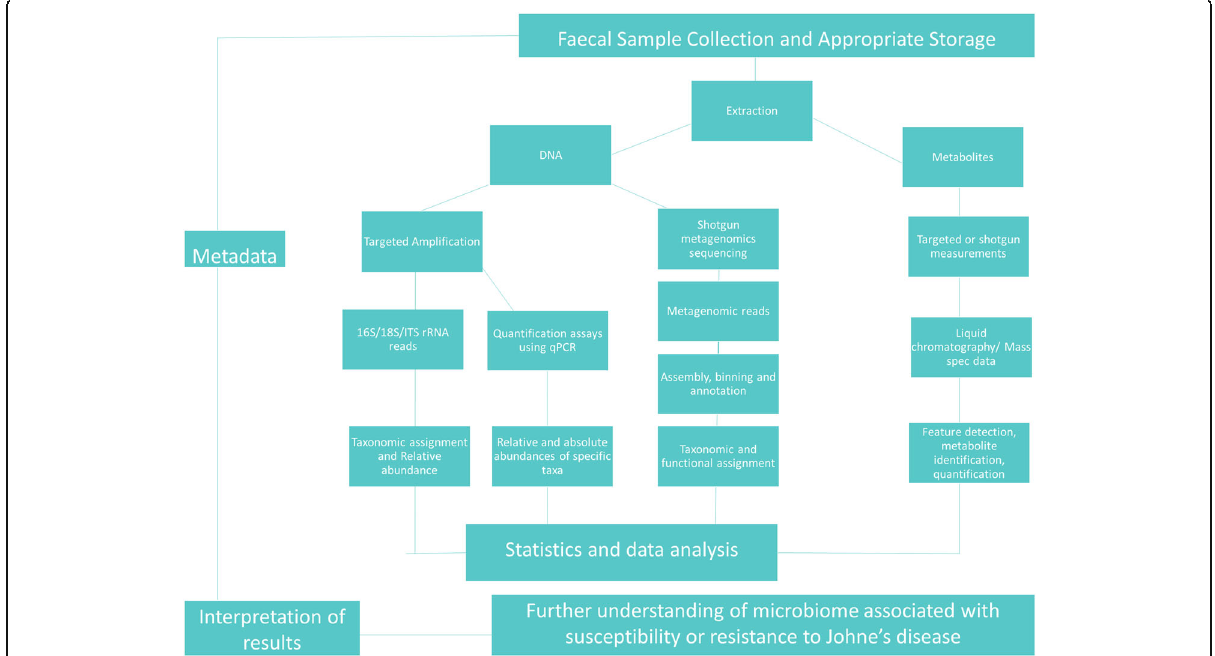
Fig. 2 Microbiome project workflow for determining the microbiome associated with JD susceptibility or resistance (Adapted from Matthews et al.